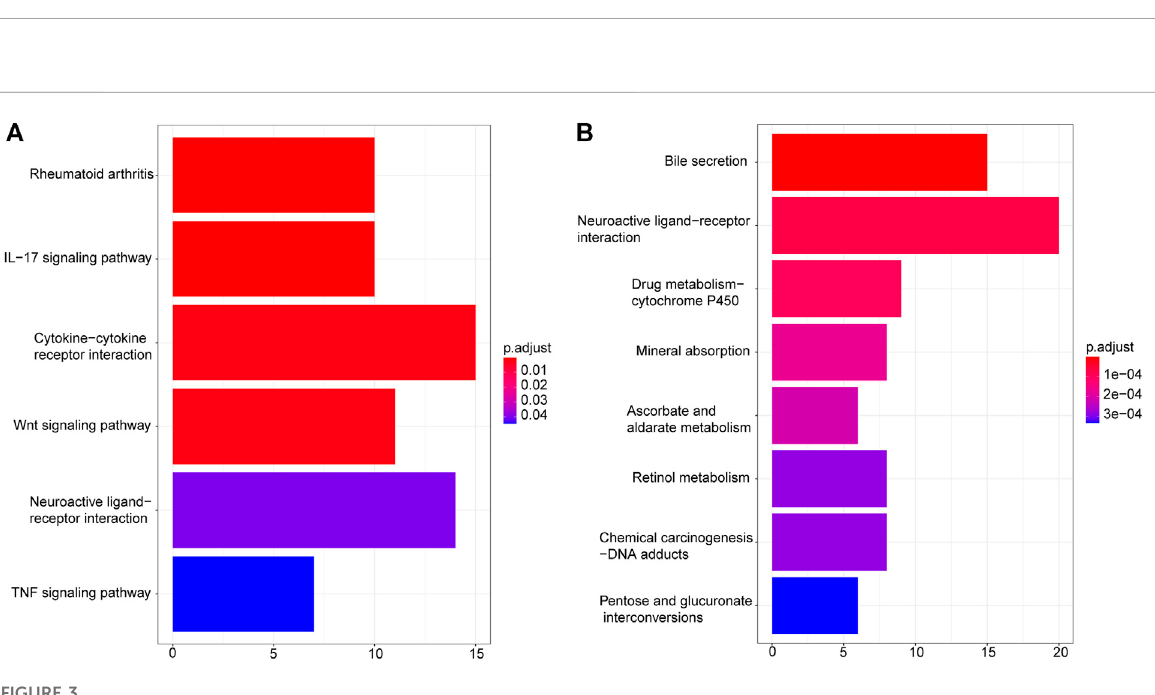
FIGURE 3 KEGG enrichment analysis of DEGs. (A) . Upregulated DEGs. (B) Downregulated